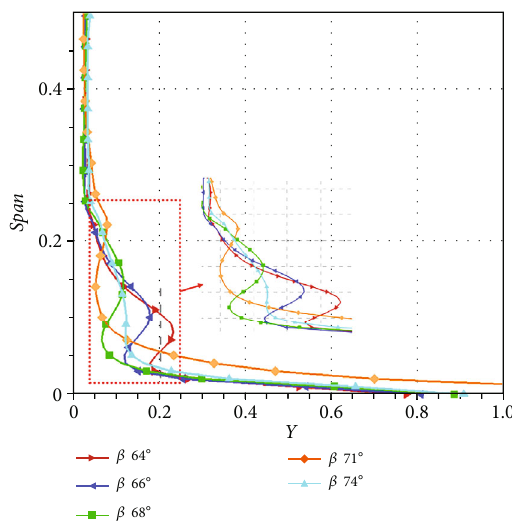
Figure 14: Comparison of total pressure loss coe ffi cient for di ff erent exit angles.